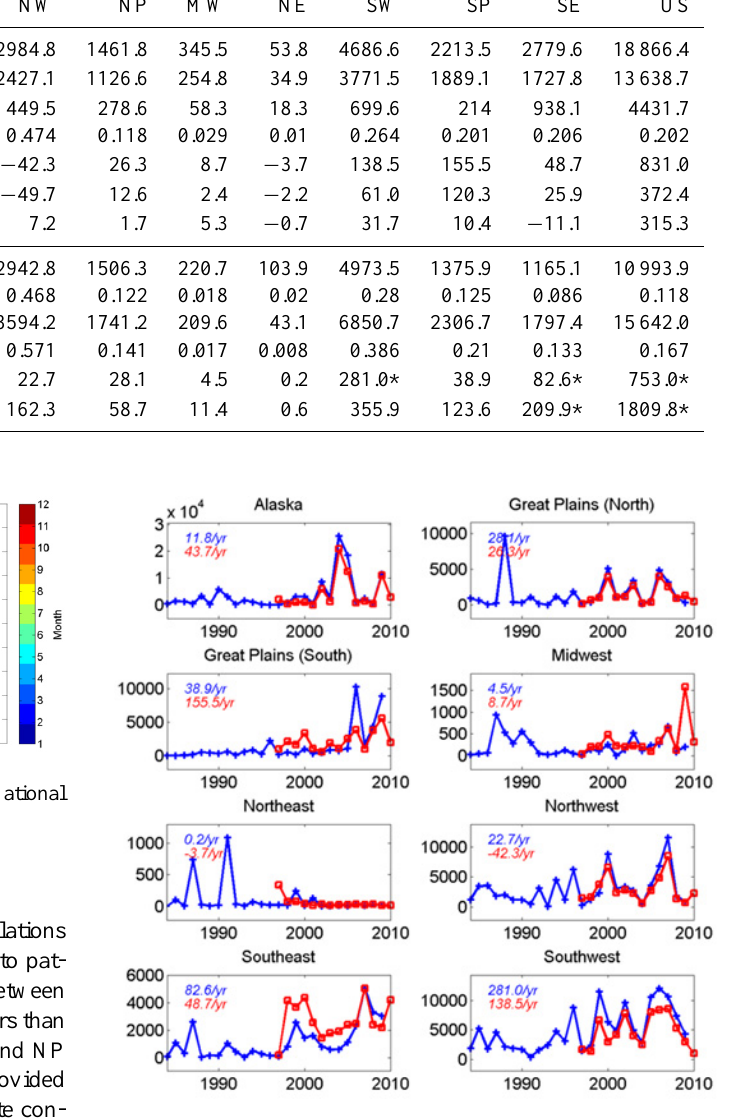
Fig. 4. Interannual variability in MTBS (blue) and GFED (red) BA for each NCA region. Values in each panel indicate the trends in annual BA (km 2 yr − 1 ) from robust linear regression for MTBS (1984–2009) and GFED (1997–2010) BA time series, as shown